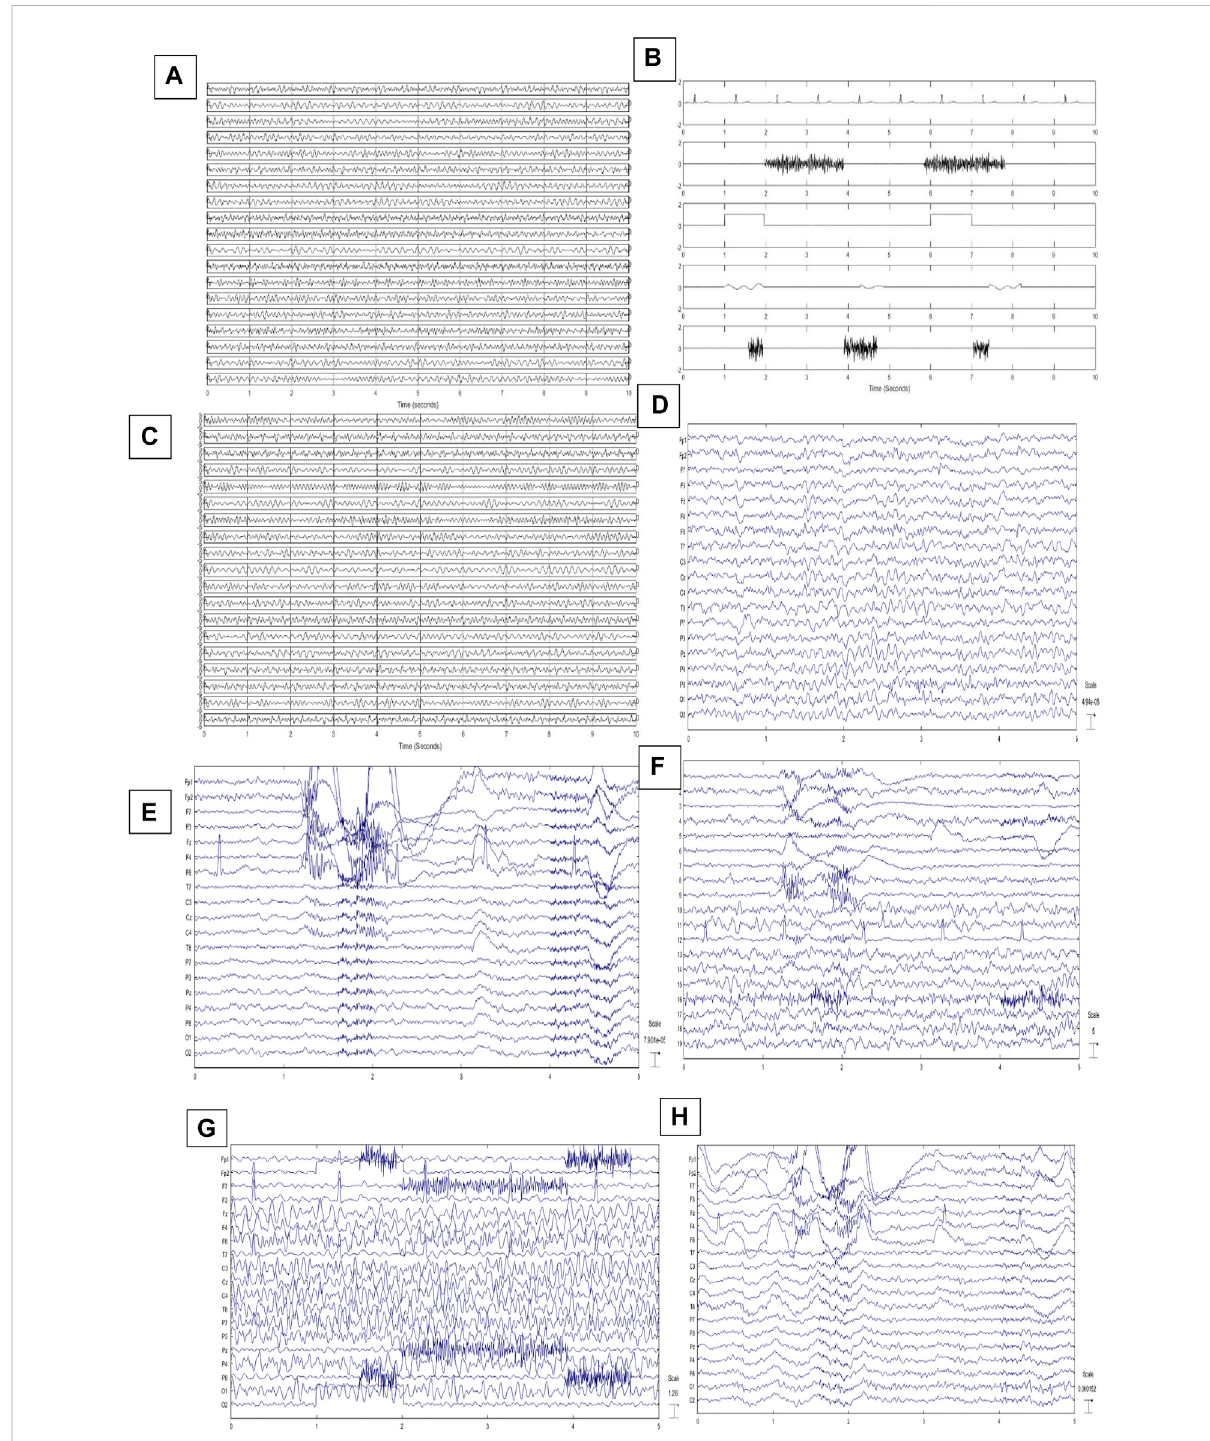
FIGURE 3 (A) 10-s illustration of PSEEGs, (B) Synthesized artifacts, (C) SCEEGs by projecting artifacts at SNR (cid:2) 0 . 5 db , (D) An example for recorded PREEG for 5 s, (E) RCEEGs of a subject for 5 s, (F) extracted sources using SOBI algorithm, (G) Illustration of 19-channel SSCEEG1s at SNR (cid:2) 0 . 5, (H) An illustration of SSCEEG2s at SNR (cid:2) 0 . 5 db